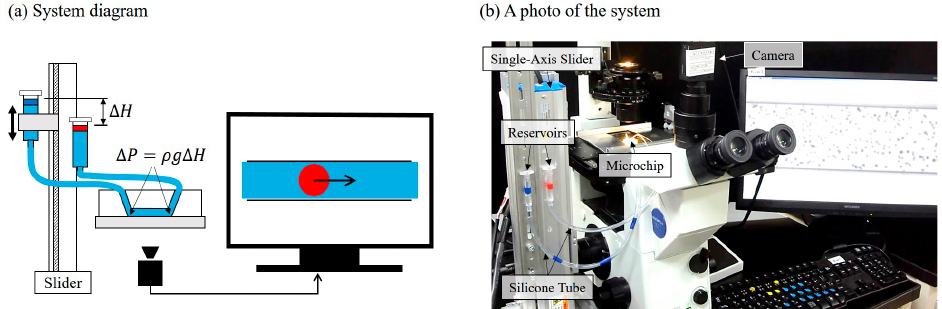
Figure 2. The overview of the experimental system. ( a ) Microfluidic flow is monitored through a camera while the slider is controlled by the signals from the computer; ( b ) A photo of the whole setup.